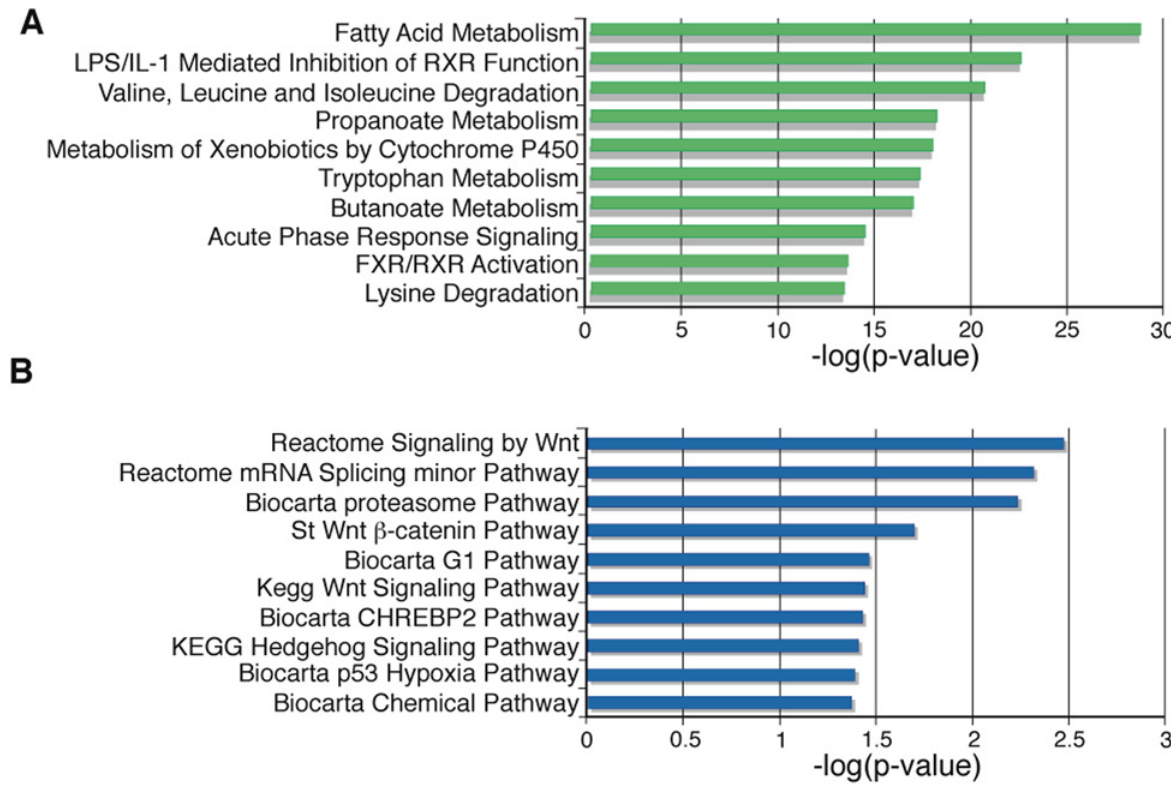
Fig 2. Pathways that distinguish the two major clusters of mouse HCC. Top ten most significantly different pathways based on gene expression of the two major clusters of mouse HCC and normal liver samples determined by GSEA (A) and Ingenuity (B).